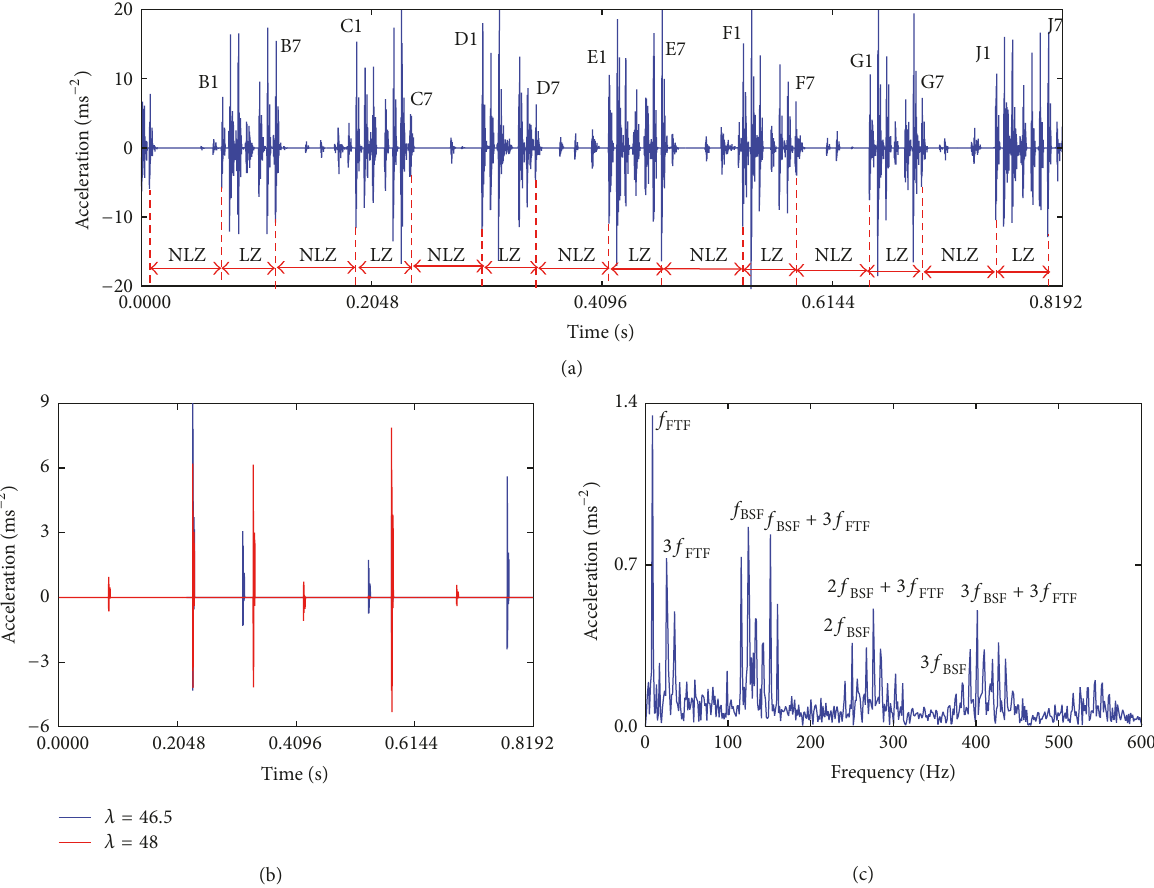
Figure 21: The extracted impulse related to atom 1: (a) by proposed appropriately sparse impulse extraction; (b) three other indicators; (c) the envelope spectra of